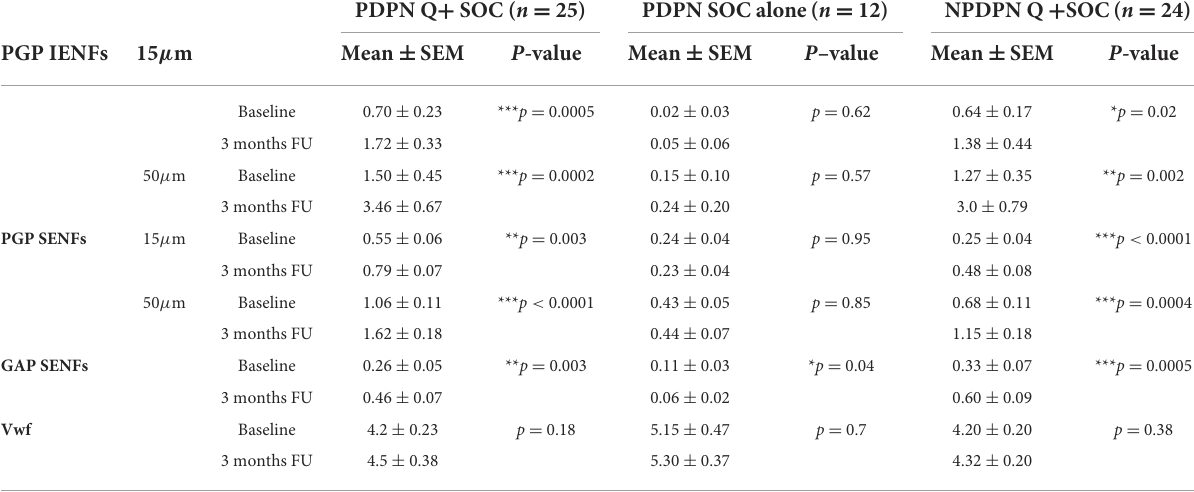
TABLE 3 Skin biopsy markers assessed at baseline and at 3 months follow–up visit in PDPN Q + SOC and PDPN SOC alone groups, for PGP 9.5 in 15 µ m and 50 µ m thick